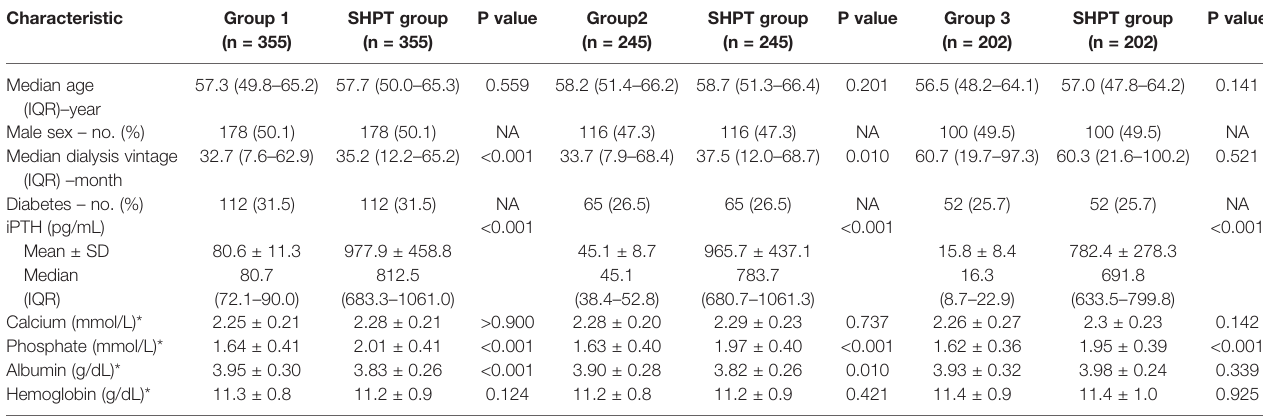
TABLE 2 | Characteristics of the patients in the matched subgroups.